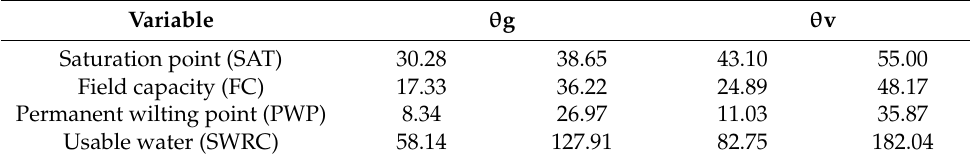
Table 3. Range of variation in soil water variables.